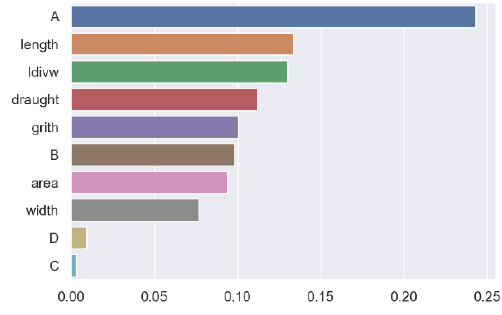
Figure 19. Static feature importance.